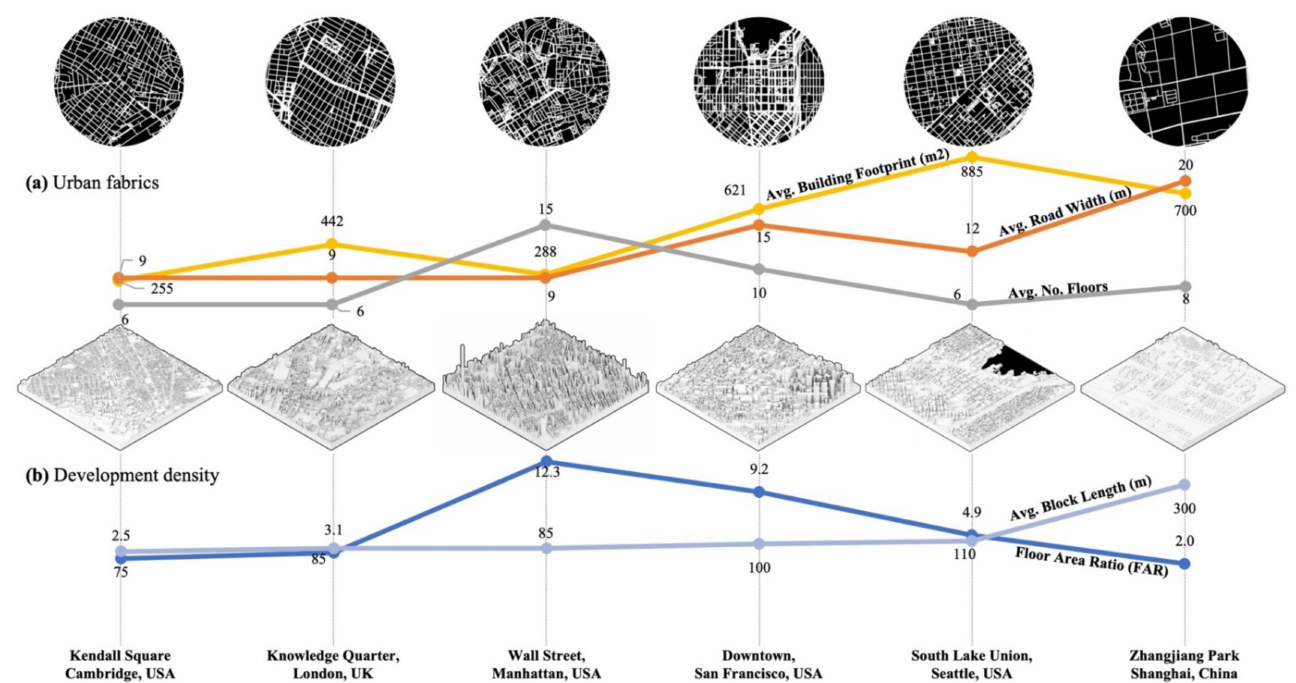
Figure 9. Comparing ( a ) urban fabrics and block metrics and ( b ) development density and metrics.